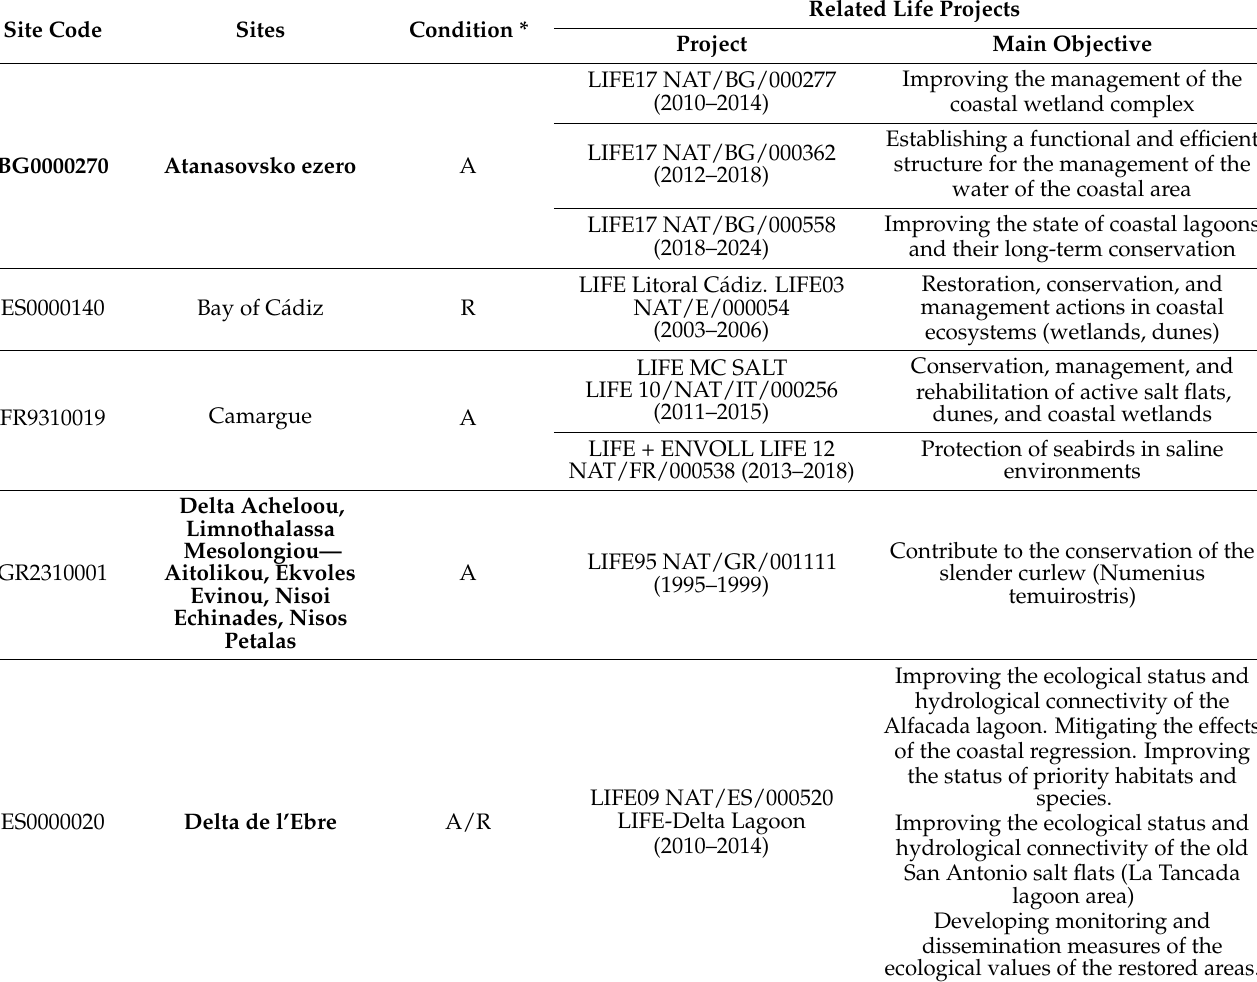
Table 1. Sites of the Natura 2000 network with industrial or artisanal salt flats and projects developed in them related to one or more of the actions proposed in this study. Site